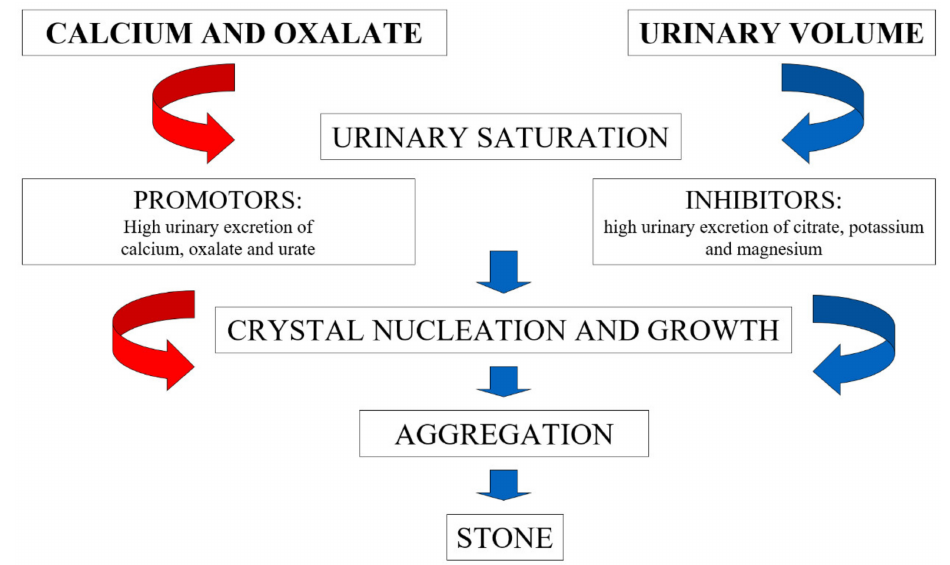
Figure 1. Mechanisms of calcium oxalate stone formation.